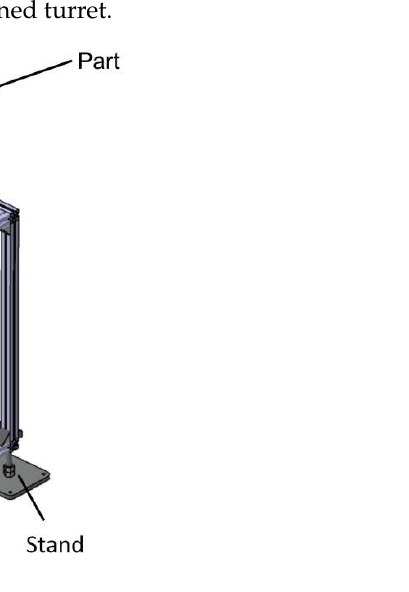
Figure 1. Location of the fixturing turrets for the anchoring of aeronautical parts (Adapted from [15]) .